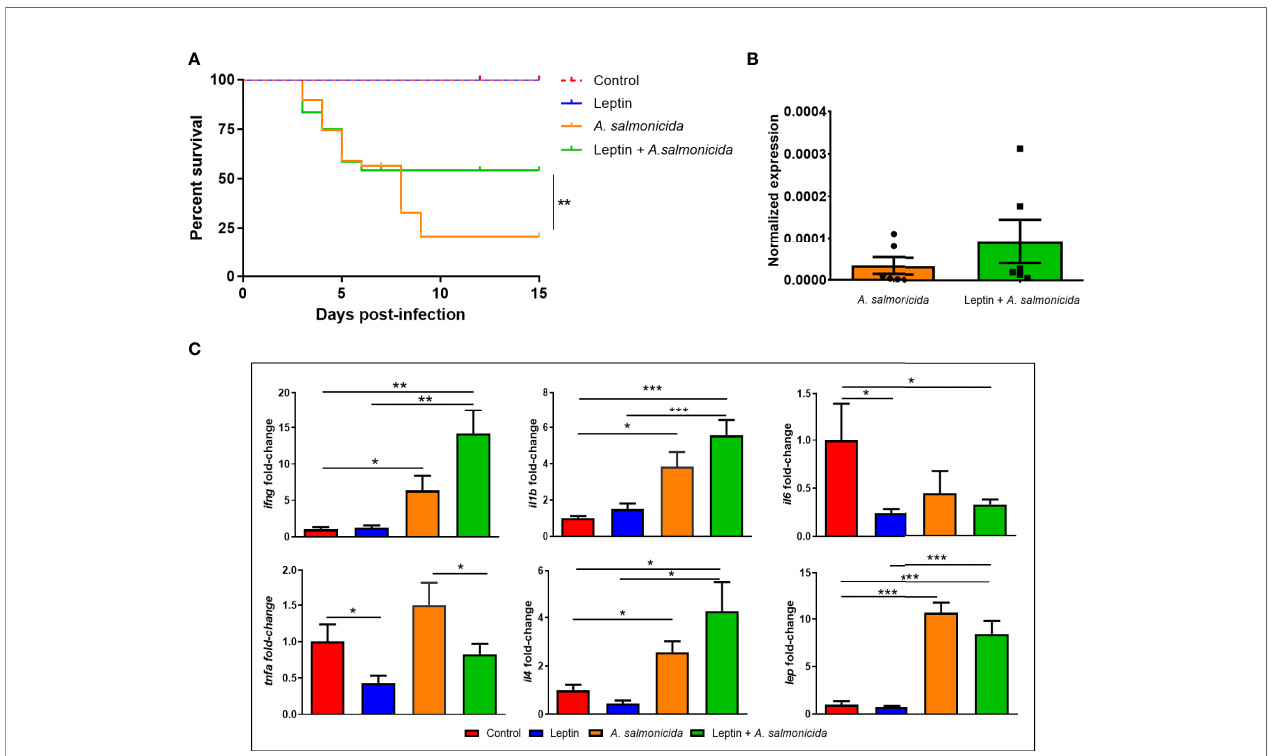
FIGURE 5 | Effect of the chronic administration of human recombinant leptin on the survival, bacterial load and expression of in fl ammation-related genes in head kidney during an infection with A salmonicida in juvenile turbot. (A) Kaplan – Meier survival curves of fi sh infected with the bacteria and treated or not treated with leptin and the corresponding uninfected controls. The graph represents the results of one of the three independent experiments conducted (n = 20). Survival curves were analysed for statistical signi fi cance with the log-rank (Mantel – Cox) test. Statistically signi fi cant differences are displayed as ** (0.01 ≤ p ≥ 0.001). (B) qPCR detection of A salmonicida subsp. salmonicida in head kidney samples from infected fi sh at 24 hpi. The bacterial signal was normalized to the expression of eef1a. (C) Gene expression analysis of in fl ammation-related cytokines in head kidney at 24 hpi. The expression level of each gene was normalized to the expression of eef1a and expressed as the fold-change with respect to the levels detected in the control group. Data represent the mean + SEM of 6 individuals. Statistically signi fi cant differences are displayed as *(p ≤ 0.05), **(p ≤ 0.01) or ***(p ≤